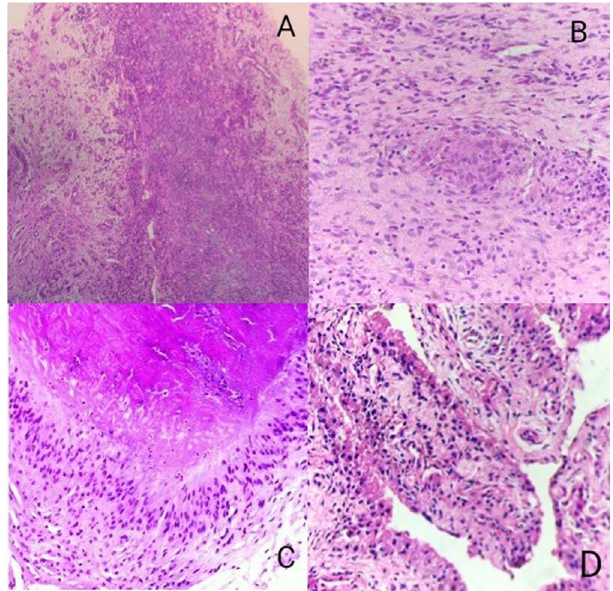
Figure 2. Figure depicting the 40 (cid:1) microscopic views of various etiologies of monoarticular synovitis of the knee (A – chronic synovitis, B – tubercular granulomatous in fl ammation, C – rheuma- toid arthritis and D – pigmented villo-nodular synovitis of